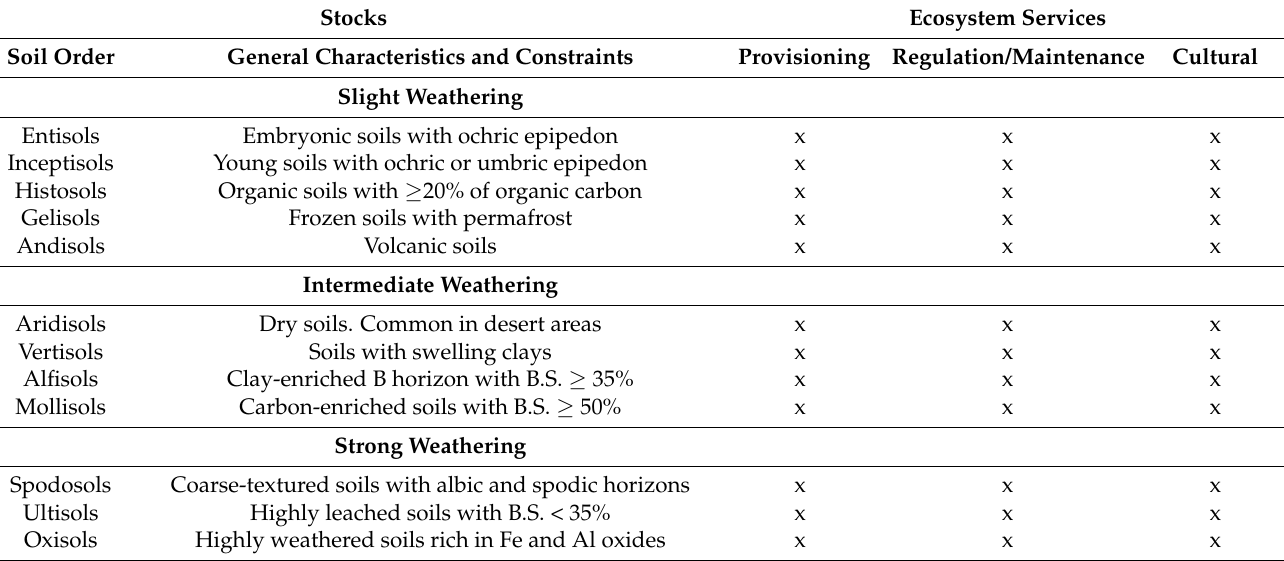
Table 6. Soil diversity (pedodiversity) is expressed as taxonomic diversity at the level of soil order and ecosystem services